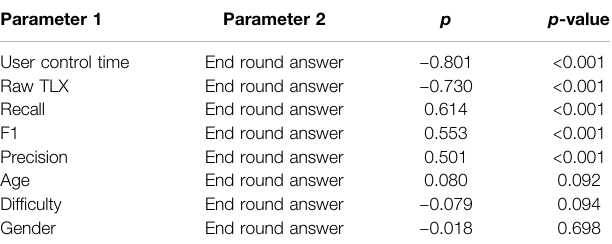
TABLE 3 | Spearmans correlation tests between participants ’ behavioral metrics (performance and reliance) and reported trust ratings. A higher ρ scores indicates greater